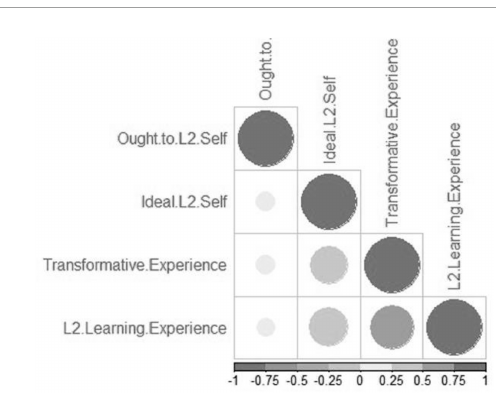
FIGURE1 Regression plot of L2 motivational self-system subcomponents with transformative